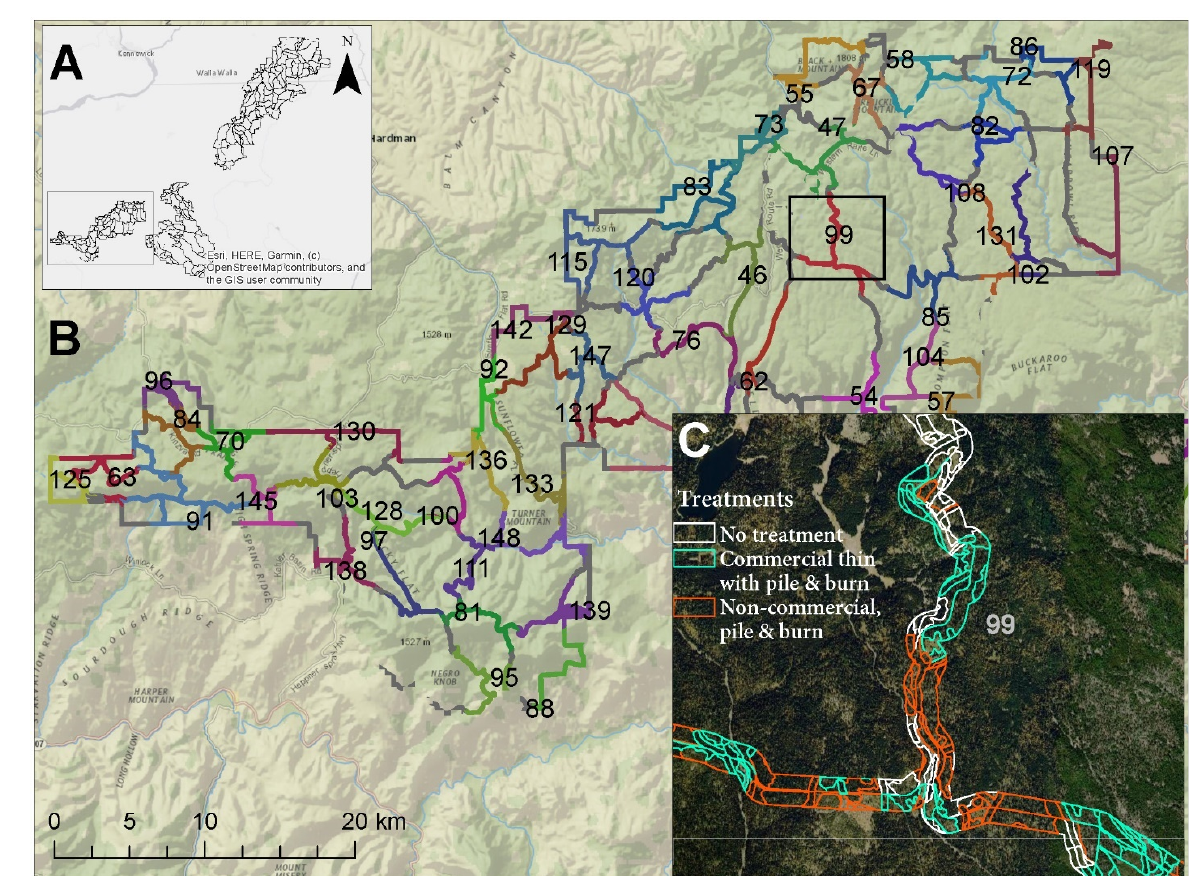
Figure 7. Illustration of the 133 sequenced projects from the 300 ha treated area scenario prioritizing multi-objectives. ( A ) Full extent of the fuel break network on the Umatilla National Forest. ( B ) Project area distribution in the southwestern part of the forest. ( C ) Fuel break treatment units within project area 99 overlaid on aerial photos across forest and non-forest grass-shrub vegetation. Stand treatments include commercial thinning with the pile and burn method; non-commercial thinning, with the pile and burn method; and no treatment (conducted in forested stands with < 15% CC or grassland/shrubs).